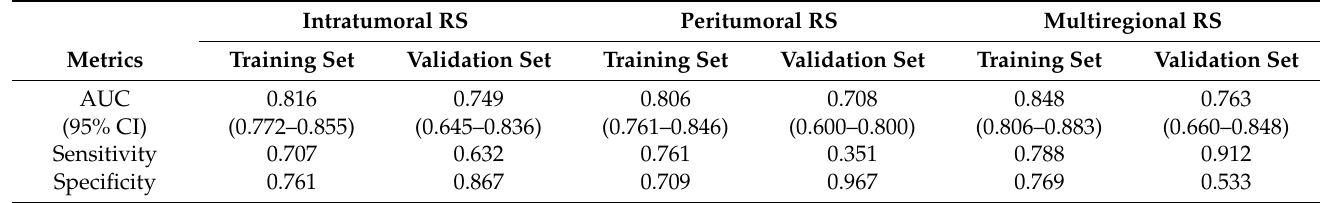
Figure 4. The receiver operating characteristic curves of the intratumoral RS ( a ), the peritumoral RS ( b ), and the multiregional RS ( c ) for predicting the progesterone receptor status in the training and validation sets. Table 3. Diagnostic performances of three RSs for predicting progesterone receptor status in the training and validation